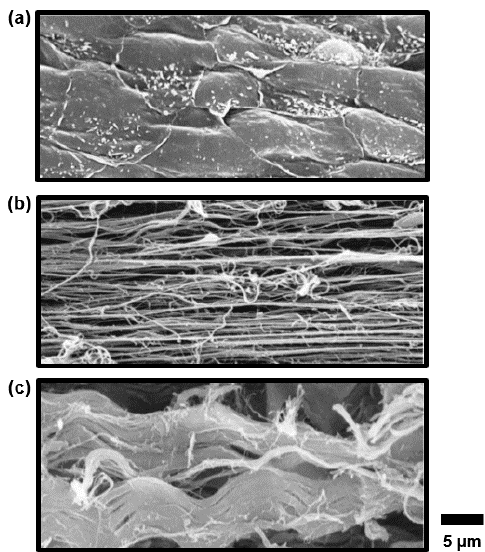
Figure 2. Scanning electron microscope (SEM) images of human mitral valve (MV) chordae tendineae, demonstrating ( a ) a layer of endothelial cells, ( b ) elastin fibers, and ( c ) undulated collagen fibers (image from Millington-Sanders et al. [22] with permission from Wiley Global).